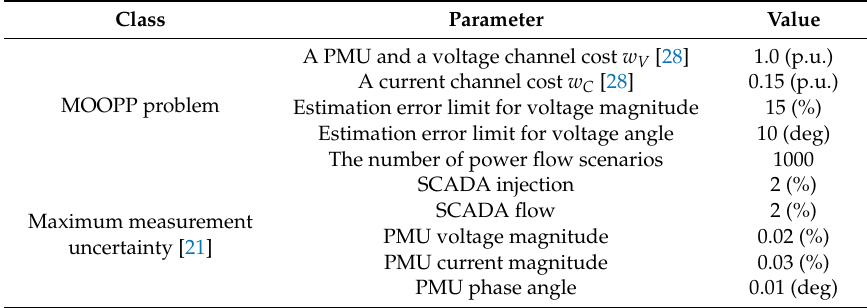
Table 3. Multi Objective OPP (MOOPP), Supervisory Control and Data Acquisition State Estimation (SCADA SE), and Hybrid State Estimation (HSE)